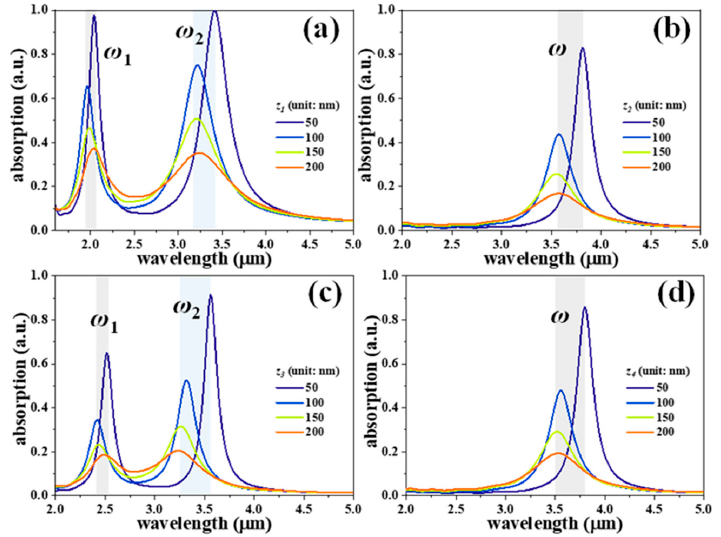
Figure 4. Absorption spectra of ( a ) SDM-1, ( b ) SDM-2, ( c ) SDM-3, and ( d ) SDM-4 with different z values, where a and b values are kept constant as a = 300 nm, and b = 200 nm, respectively. To further prove the proposed SDMs for sensing applications, the four SDMs were designed to be exposed to ambient environments with different refraction indexes ( n i ) to demonstrate the high-efficient and high-sensitive sensor applications. Figure 5 shows the absorption spectra of the SDMs by changing the surrounding refraction index from 1.0 to 1.4, where the z , a , and b values are kept constant as z = 50 nm, a = 300 nm, and b = 200 nm, respectively. SDM-1 shows the absorption resonances are red-shifted from the wave- length of 2.04 µm to 2.83 µm and from the wavelength of 3.42 µm to 4.74 µm for ω 1 and ω 2 , respectively, by increasing the n 1 value from 1.0 to 1.4 as shown in Figure 5a. The ab- sorption intensities are stable at 99.9%. As shown in Figure 5b, the absorption resonances are red-shifted from the wavelength of 3.81 µm to 5.29 µm for SDM-2 by increasing the n 2 value, while the absorption intensities increase minorly from 82.8% to 89.5%. SDM-3 shows the absorption resonances are red-shifted from the wavelength of 2.54 µm to 3.46 µm and from the wavelength of 3.56 µm to 4.89 µm for ω 1 and ω 2 , respectively, by increas- ing the n 3 value as shown in Figure 5c. The absorption intensities increase gradually from 64.9% to 75.3% and from 91.4% to 95.4% for ω 1 and ω 2 , respectively. As for SDM-4, the absorption resonances are red-shifted from the wavelength of 3.80 µm to 5.24 µm by in- creasing the n 4 value, while absorption intensities increase minorly from 85.8% to 91.1% as shown in Figure 5d. The four SDMs exhibit refraction index-sensitive features that indicate that absorption resonances are red-shifted by increasing n i values. It can be explained that the relative permittivity of the surrounding insulator layer changed, resulting in the change of resonant frequency [17].